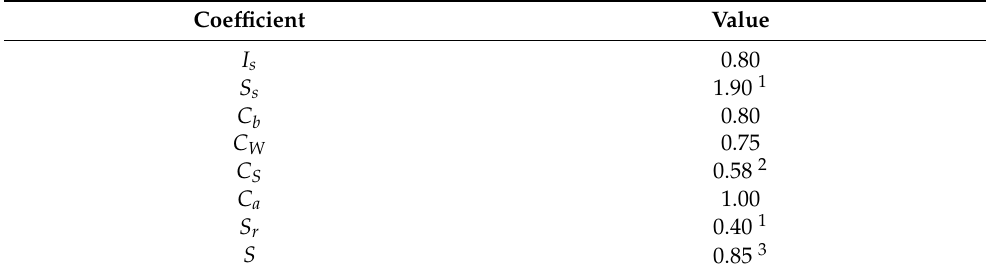
Table A1. Design Snow Load. Note that the minimum specified snow load is to be taken as 1.00 kPa. Coefficient Value I s